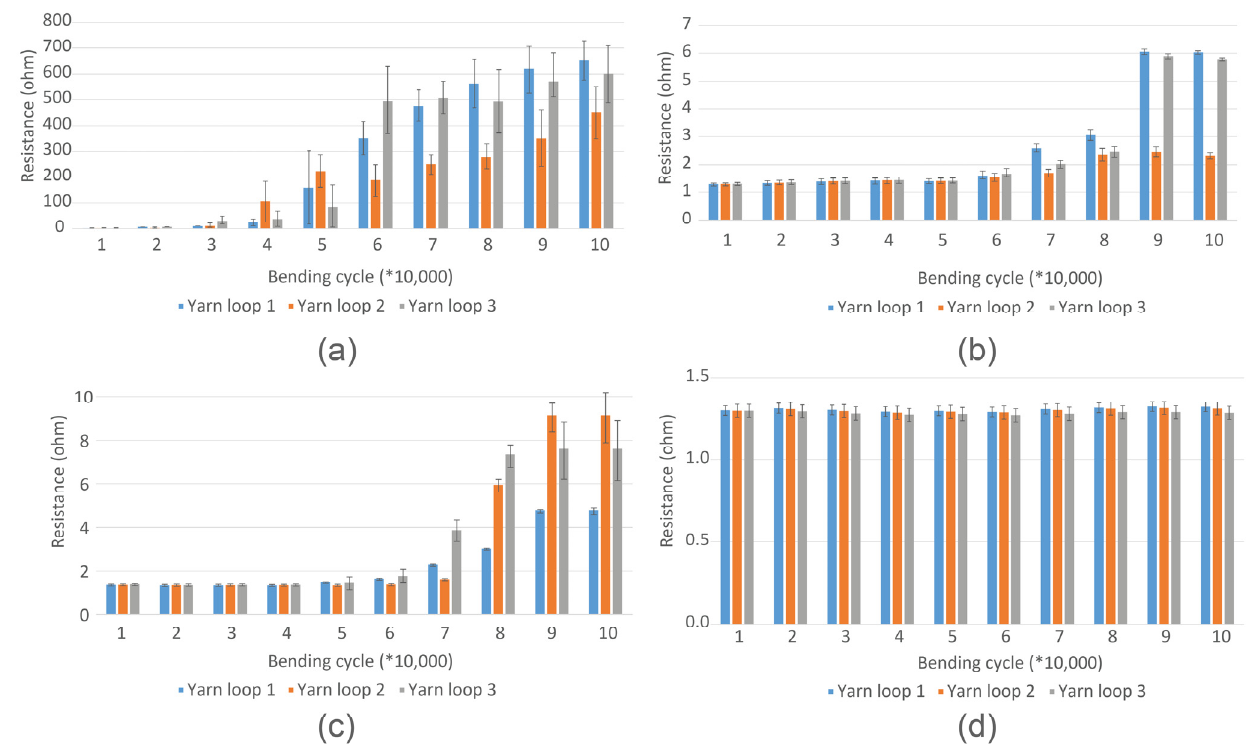
Figure 4. Overview of the results displaying the average resistance of each 10,000 (*10,000) cycle set. ( a ) Sample set 1 with Yarn 1. ( b ) Sample set 2 with Yarn 2. ( c ) Sample set 3 with Yarn 1. ( d ) Sample set 4 with Yarn 2.